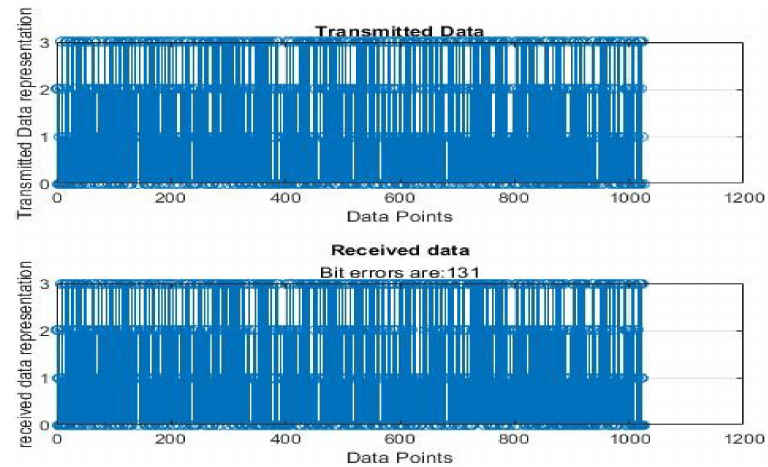
Figure 15. Customary QPSK output for 1024 data points in a noisy channel.